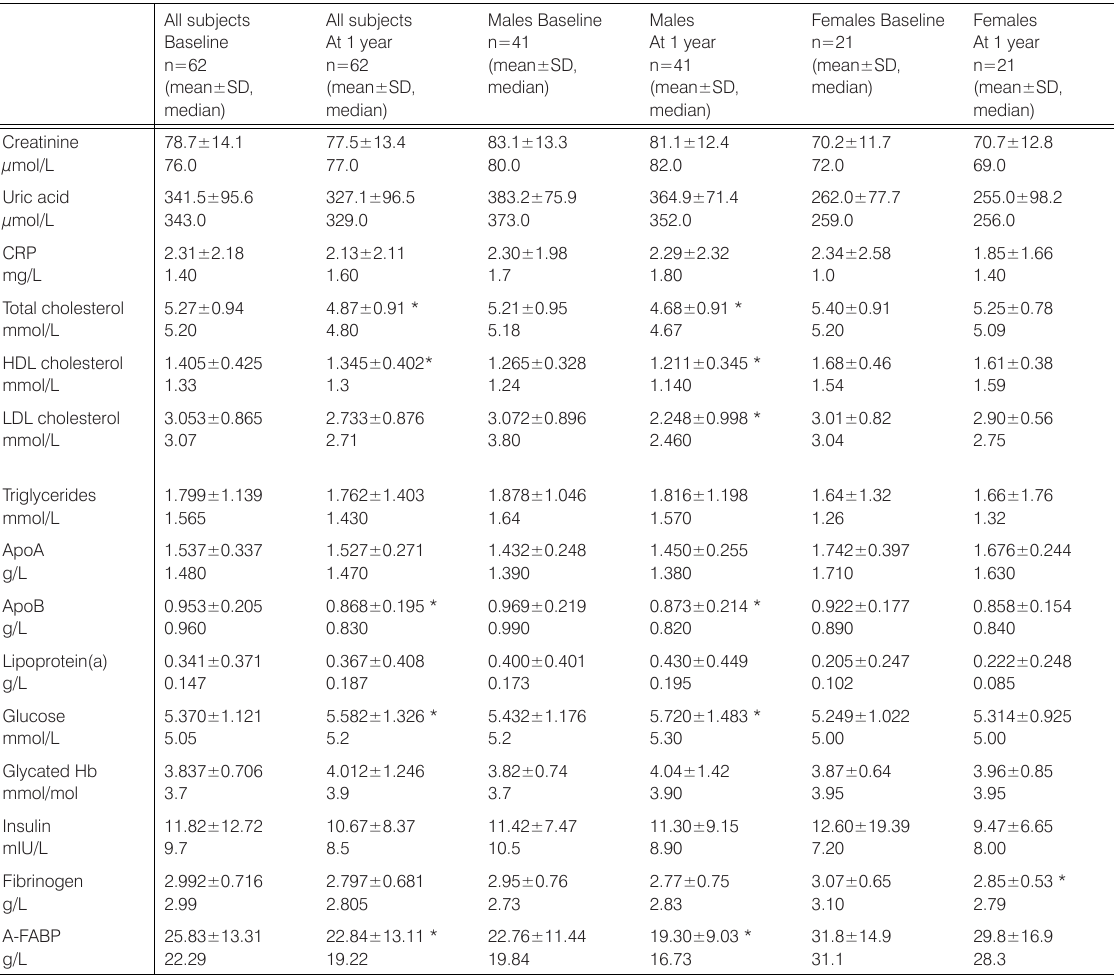
Table 2. Studied laboratory parameters in all subjects, males, females